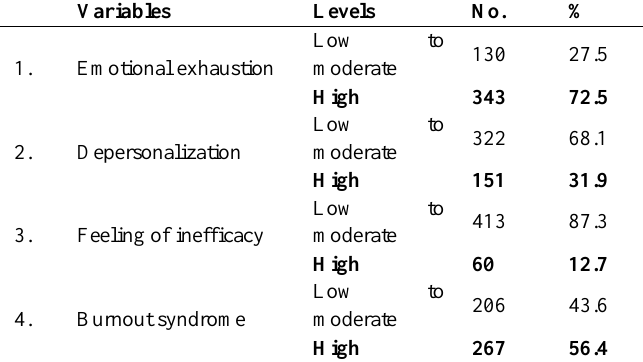
Table 2 : Distribution of burnout syndrome (BOS) and